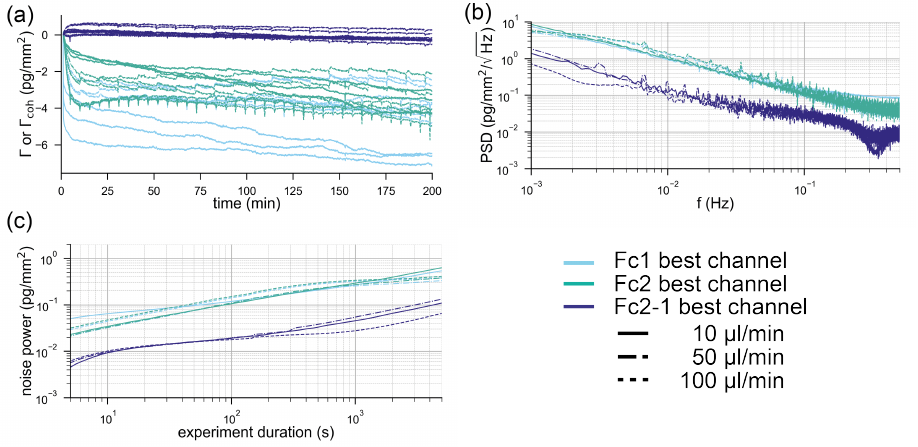
Figure A2. Surface mass resolution dependence of the refractometric readout as a function of focal distance: ( a ) improved resolution of the refractometric readout for increasing focal distances thanks to larger mechanical tolerances. The dotted points are the measured root mean square (rms) values, whereas the grey dashed line is the sensitivity of the mass density with respect to lateral shifts as a function of focal distance. The reduced sensitivity of the sensor output for displacements of the Airy disk is the main reason for this behavior. Resolutions were calculated after drift subtraction over one hour. ( b ) The shape of the focal spot in the xy and xz planes is shown for molograms with increasing focal distance, visually illustrating the increasing mechanical tolerances with focal distance. A small schematic illustrates the relative distance of the focal plane with respect to the chip surface for the four molograms. All intensity contour plots have a 0.25 power norm scaling for better visualization.